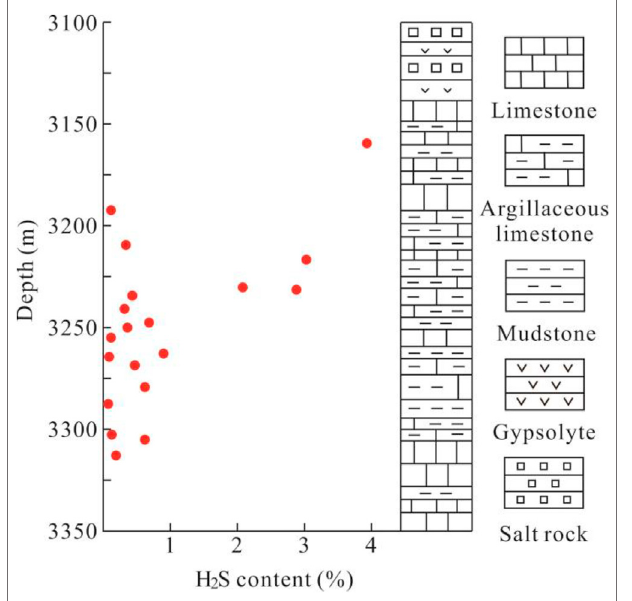
FIGURE 4 | The relation between H 2 S content and the burial depth.